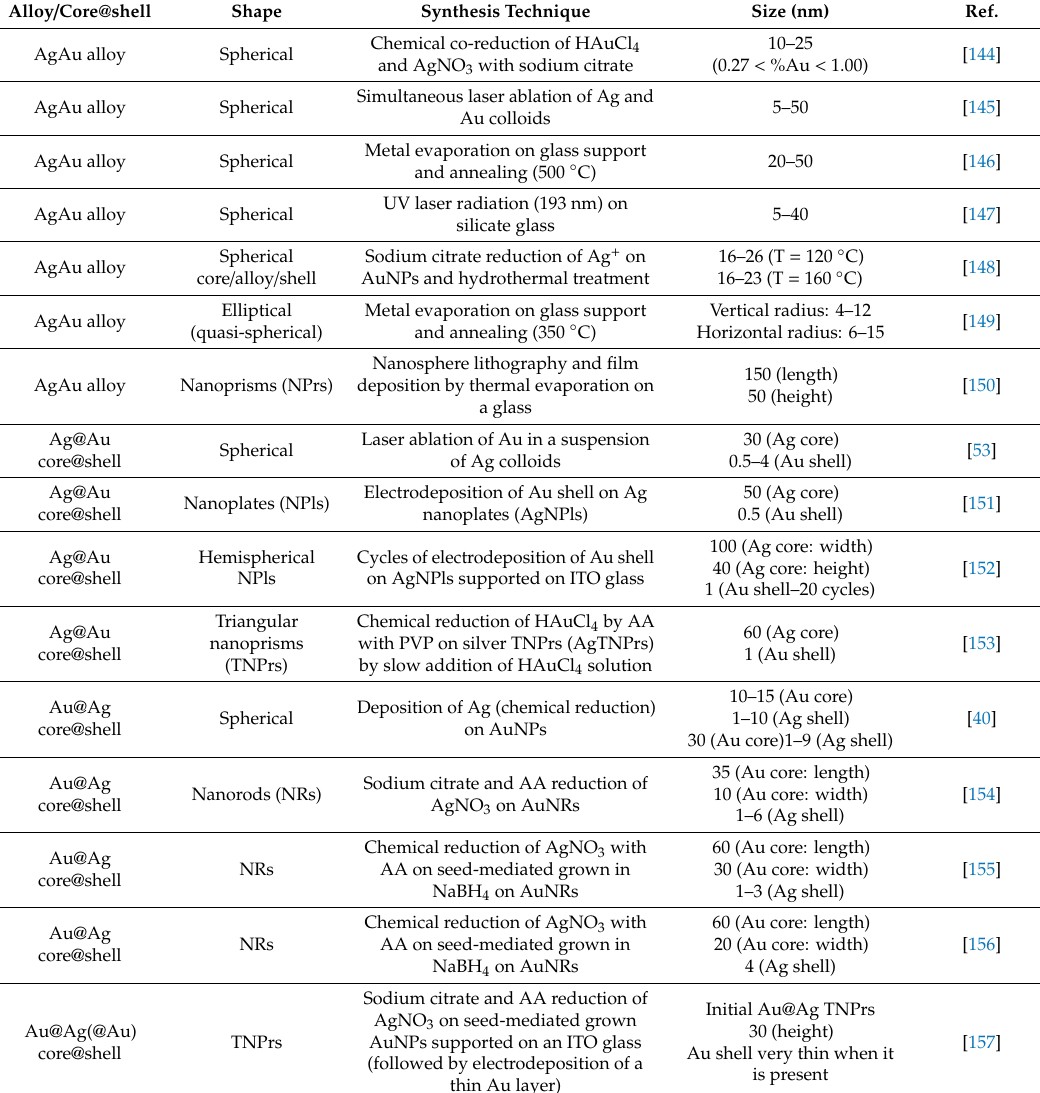
Table 3. Summary of the main Ag-Au bimetallic NPs structures: synthesis techniques, size and